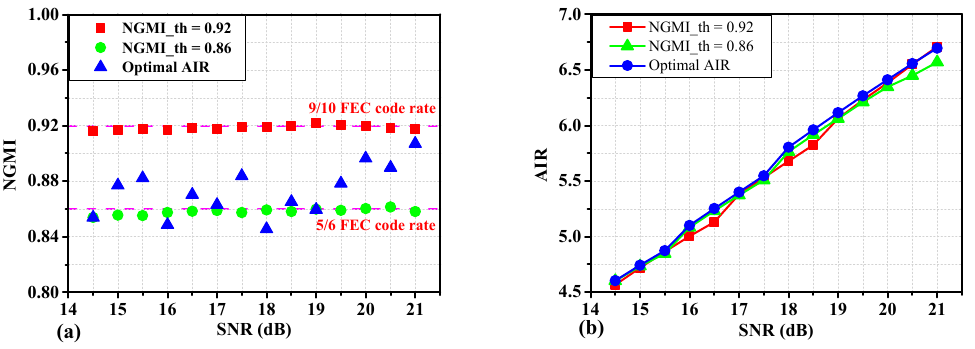
Figure 7. The NGMI and AIR simulation performance of scenario 1 to 3.